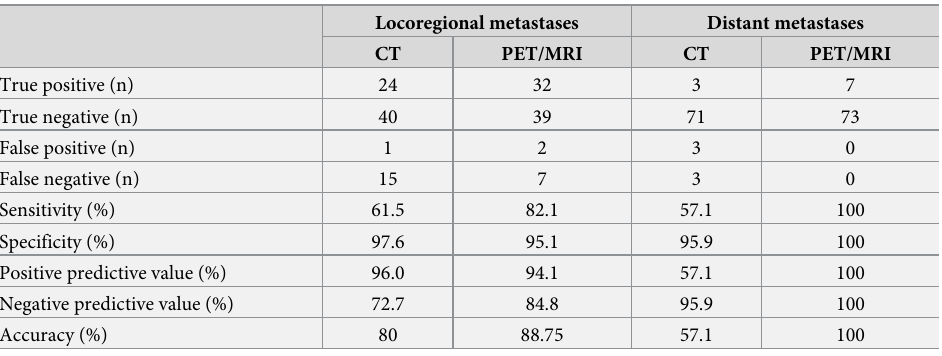
Table 2. Diagnostic performance of CT and PET/MRI on a patient-based